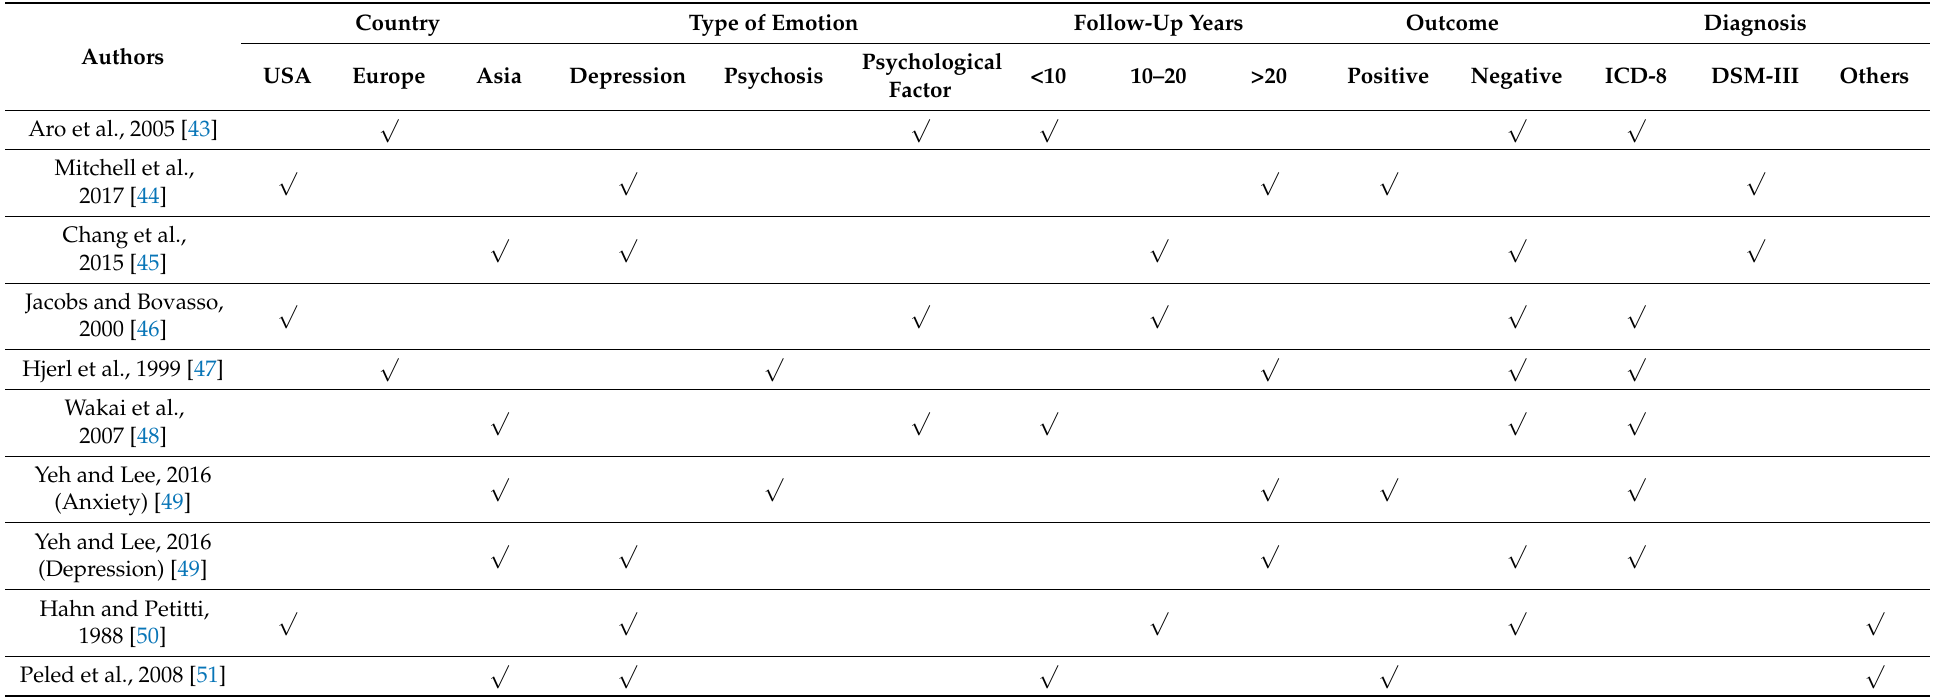
Table 3. The characteristics of the